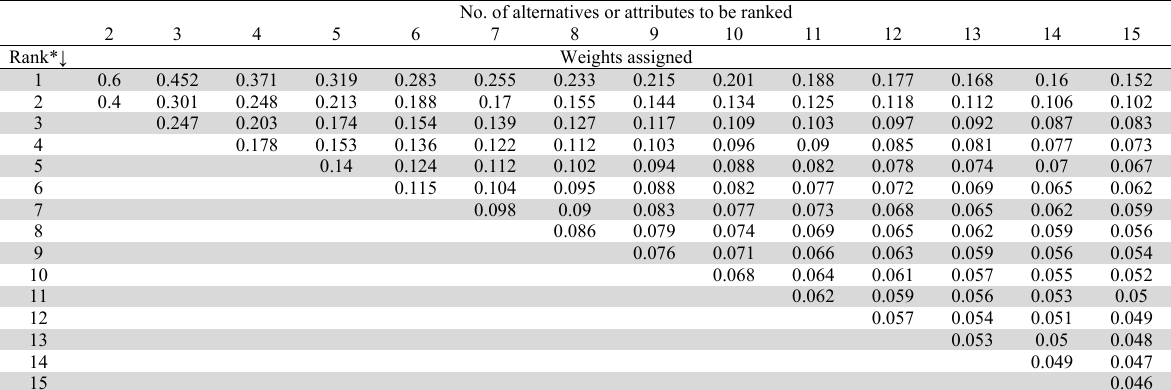
Weights assigned to different ranks of the alternatives and attributes